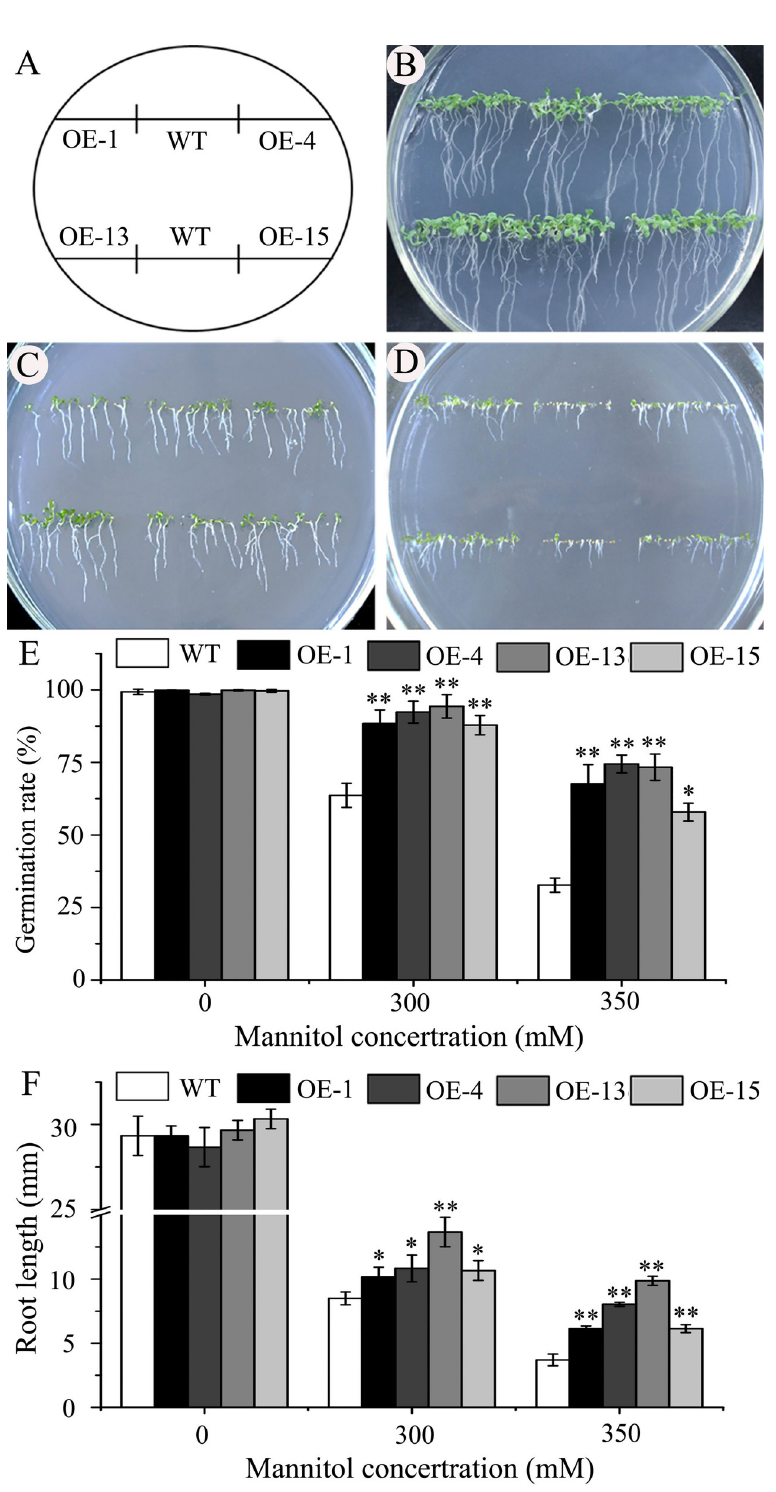
Fig 4. Constitutive expression of AmDREB3 enhanced osmotic stress tolerance of transgenic Arabidopsis at the germination stage. (A) The location of transgenic lines and wild-type (WT) Arabidopsis on different medium plates. (B to D) After 10 d of germination on only 1/2 MS (0) and 1/2 MS plus 300 or 350 mM mannitol plates, respectively. (E and F) Germination rates and root lengths of seedlings on different media for 3 d and 10 d, respectively. Data are presented as means ± SDs (n = 3). Asterisks and double asterisks indicate significant differences of transgenic lines (OE-1, OE-4, OE-13, and OE-15) compared to wild-type (WT) at p < 0.05 and < 0.01 levels, respectively.